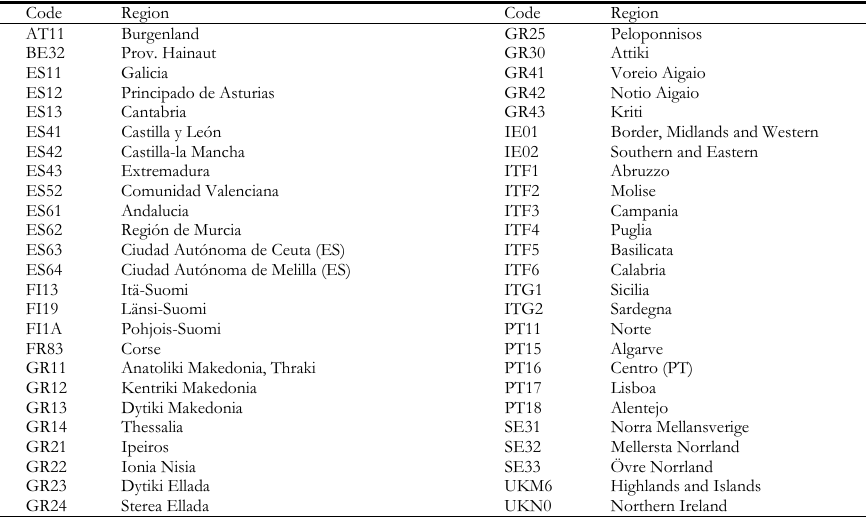
List of NUTS-2 Objective 1 regions included in the sample